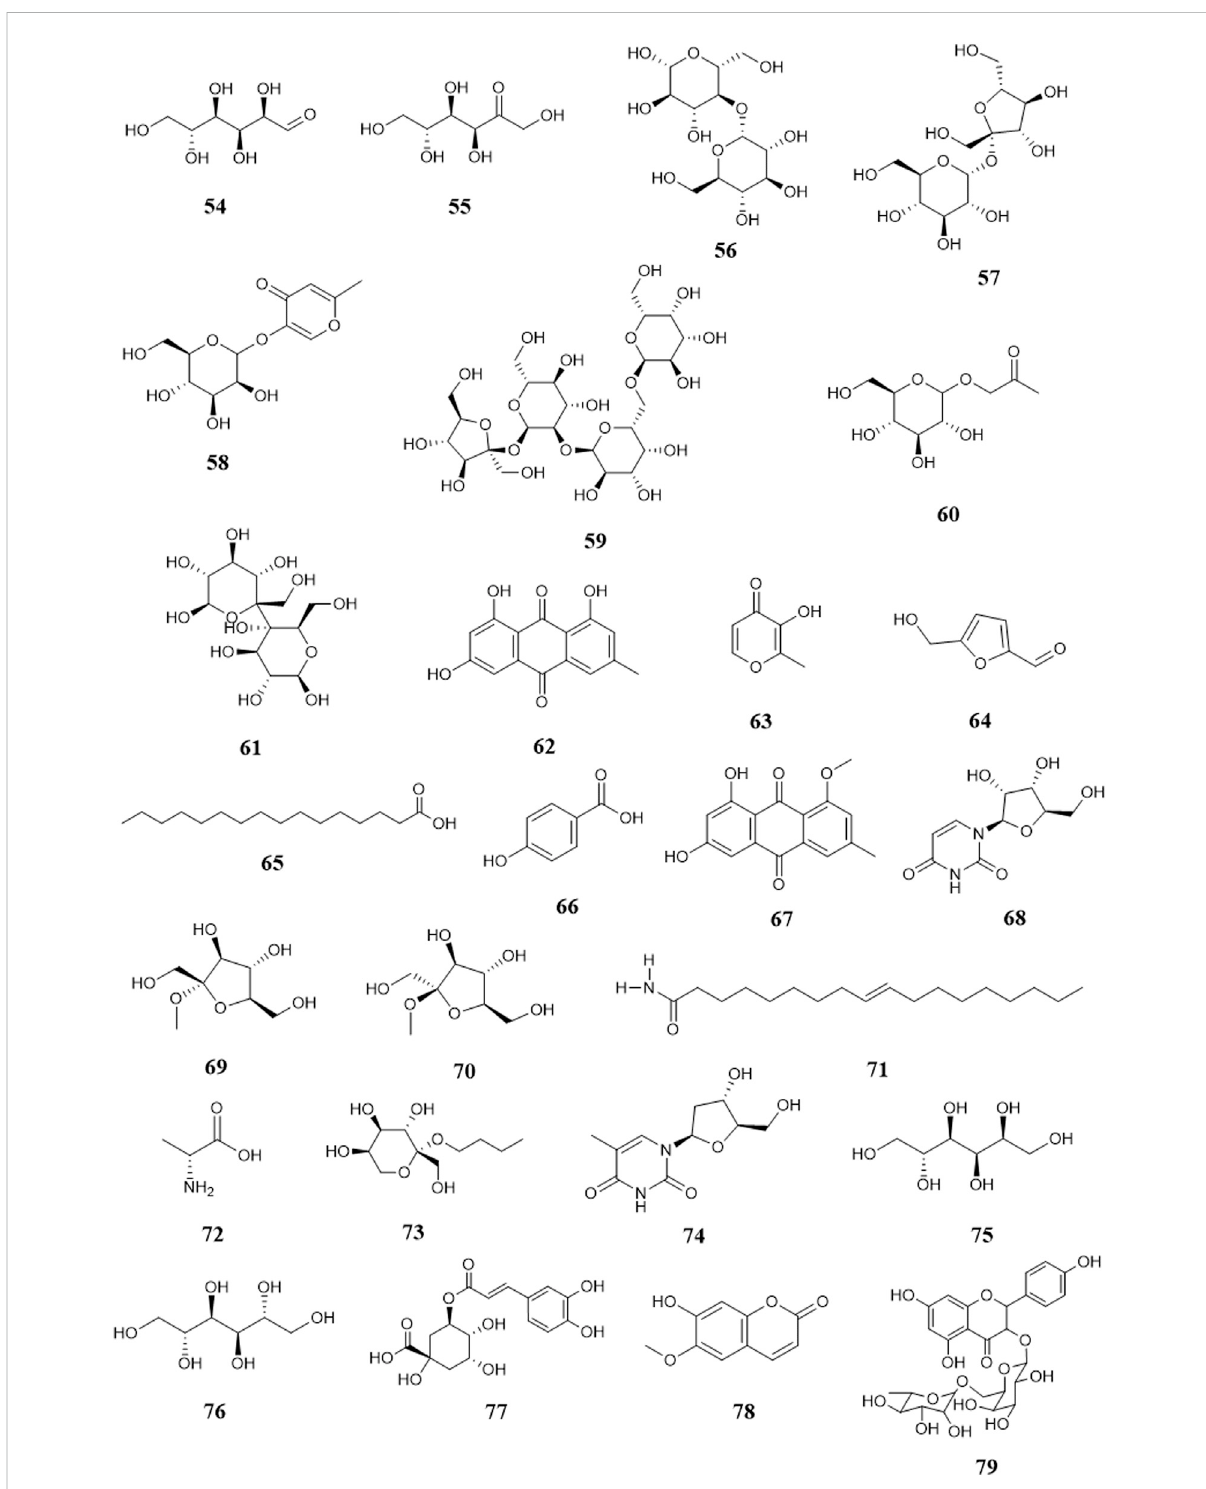
FIGURE 7 Structure of other compounds from Bolbostemma paniculatum (Maxim.)